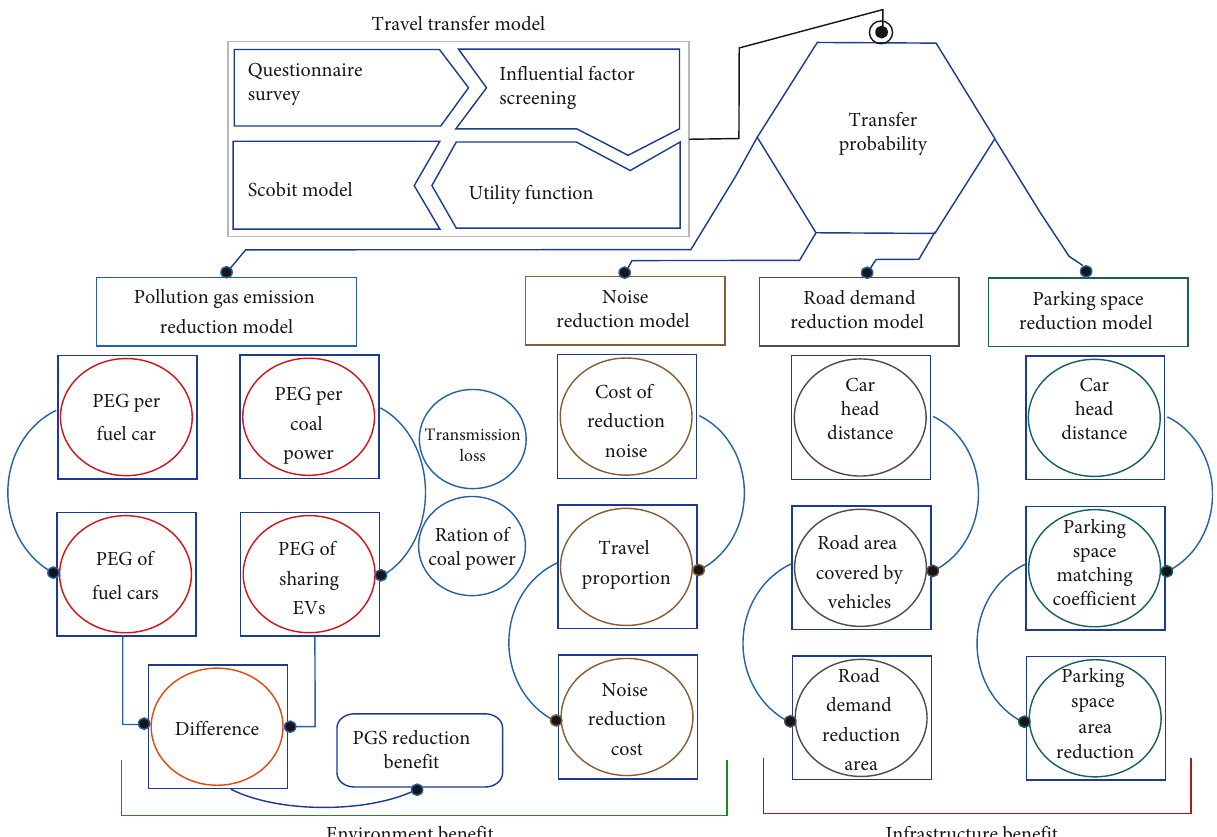
Figure 17: Travel transfer model